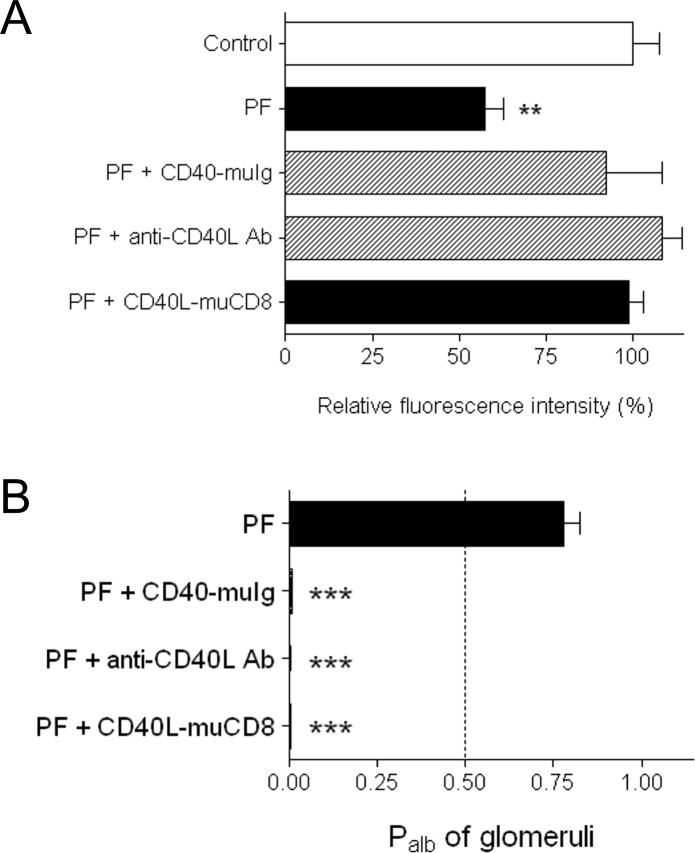
Effect of the partially purified Permeability Factor (PF), prepared from plasmapheresis eluates from patients who presented post-transplant recurrence of FSGS, on nephrin expression in cultured GECs (A) and on Permeability activity of albumin (Palb) in isolated rat glomeruli (B). (A) Semiquantitative analysis of nephrin expression as detected by immunofluorescence staining in GECs incubated with PF (500 ng/ml) for 30 min in the absence (black bar) or presence of different inhibitors of CD40-CD40L interaction. Using CD40-muIg fusion protein (20 ng/ml) and the neutralizing antibody against CD40L (5 μg/ml), hr-sCD40L was pre-treated for 10 minutes prior to GEC stimulation, whereas the CD40L-muCD8 fusion protein (10 μg/ml) was added to cultured GECs 30 minutes before adding hr-sCD40L (see Methods for details). **P < 0.01 versus unstimulated control and PF + inhibitors of CD40-CD40L interaction. Values are derived from 5 or more experiments for each experimental condition and expressed as percent variations from baseline value. (B) Permeability activity of albumin (Palb) induced by PF on isolated rat glomeruli: Palb was determined after the incubation of rat glomeruli with PF (500 ng/ml), as detailed in the Methods section. A significant increase in glomerular permeability is expressed by values of Palb greater than 0.5 (black bar). Using CD40-muIg fusion protein (20 ng/ml) and the neutralizing antibody against CD40L (5 μg/ml), hr-sCD40L was pre-treated for 10 minutes prior to glomerulus stimulation, whereas the CD40L-muCD8 fusion protein (10 μg/ml) was added to the glomeruli 10 minutes before adding PF. At least five animals were studied per each experimental group.